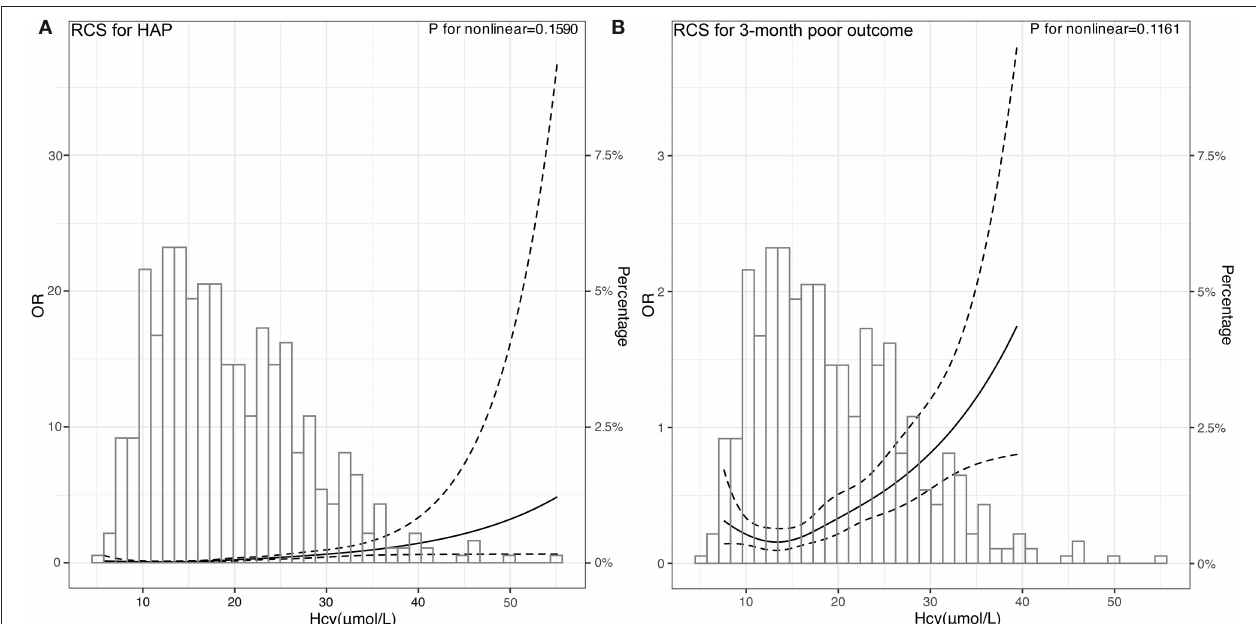
FIGURE 4 | Association of Hcy with risk of HAP and poor 3-month poor outcome. OR and 95% CI were derived from restricted cubic spline regression, with knots placed at 5th, 27.5th, 50th, 72.5th, and 95th percentiles of Hcy. The solid line represents the OR and the dashed lines represent the 95% CI. (A) OR of RCS for HAP was adjusted for the age, sex, and variables selected by stepwise logistics regression including intubation and hematoma volume. (B) OR of RCS for 3-month poor outcome was adjusted for the age, sex, and variables selected by stepwise logistics regression including HAP and hematoma volume.